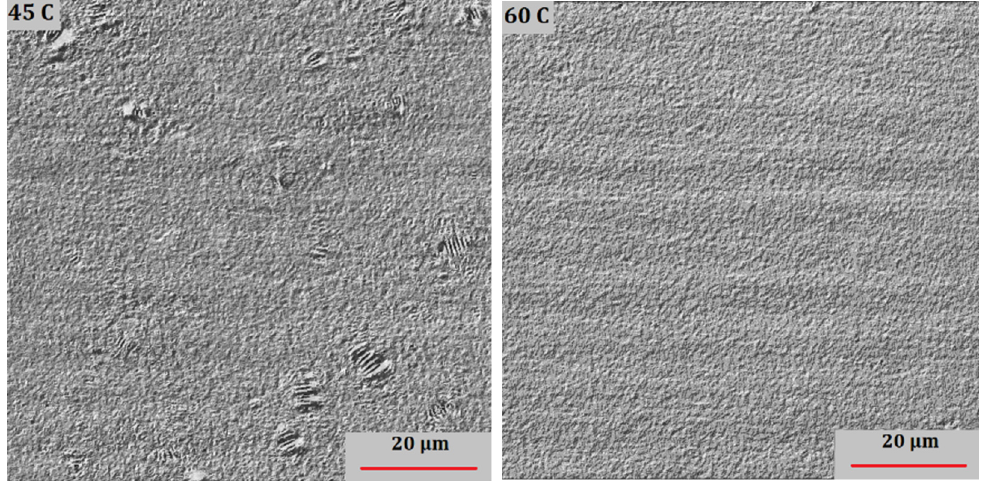
Figure 9. CLSM-DIC images of bitumen A at selected temperatures during the heating scan (1.25 °C/min) after 24 h annealing at 25